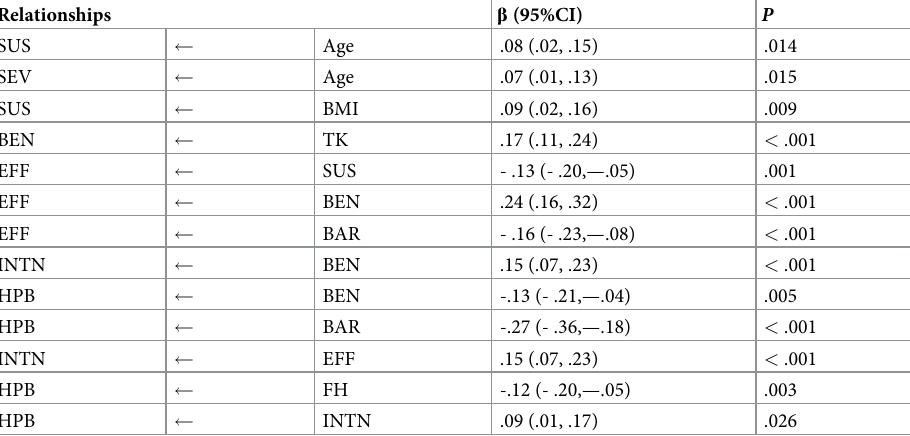
Table 3. Path relationships of the final model. Relationships